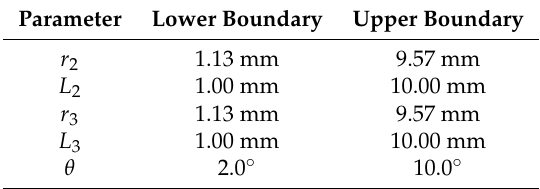
Table 4. Boundaries for the design parameters during the Genetic Algorithm optimization.